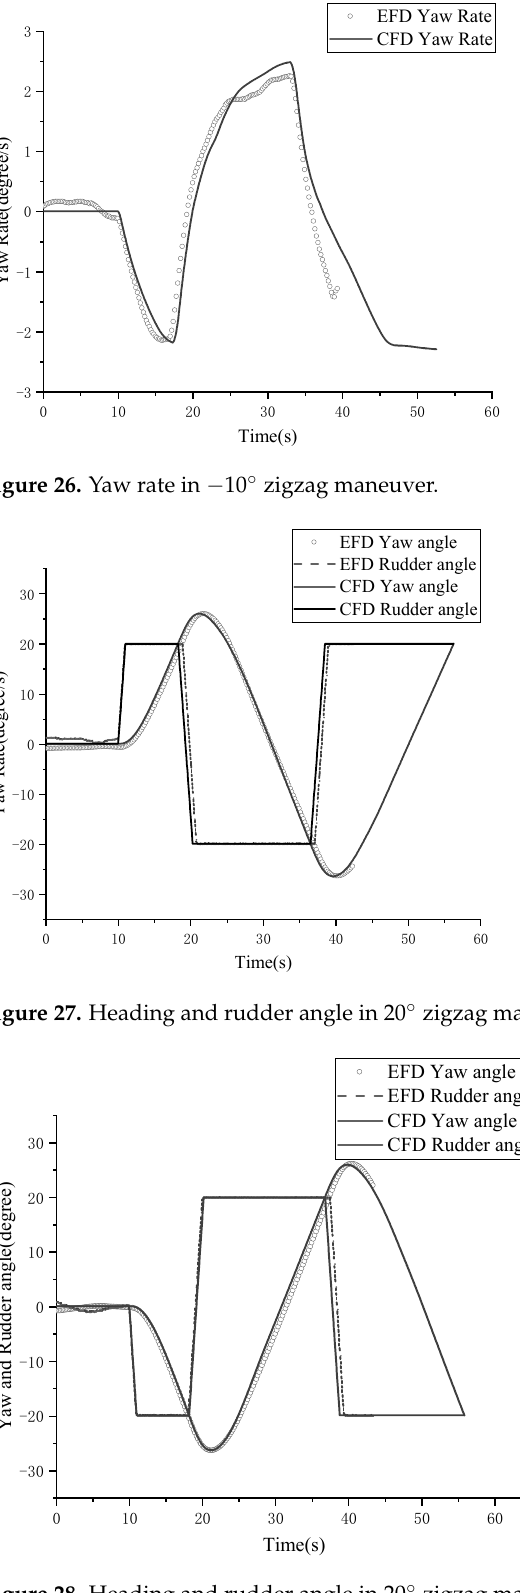
Figure 28. Heading and rudder angle in 20 ◦ zigzag